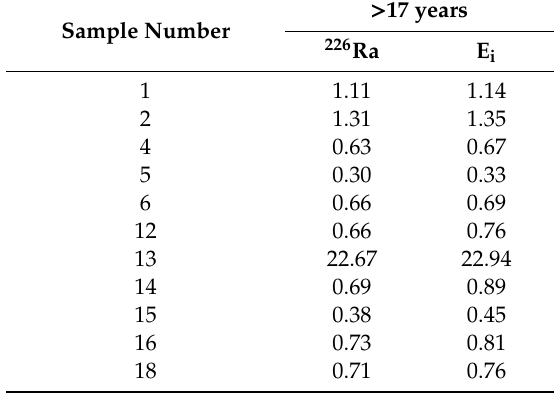
Table 4. E ff ective doses from Ra-226 and all isotopes (in µ Sv) received by adults as a result of inhalation of mineral water